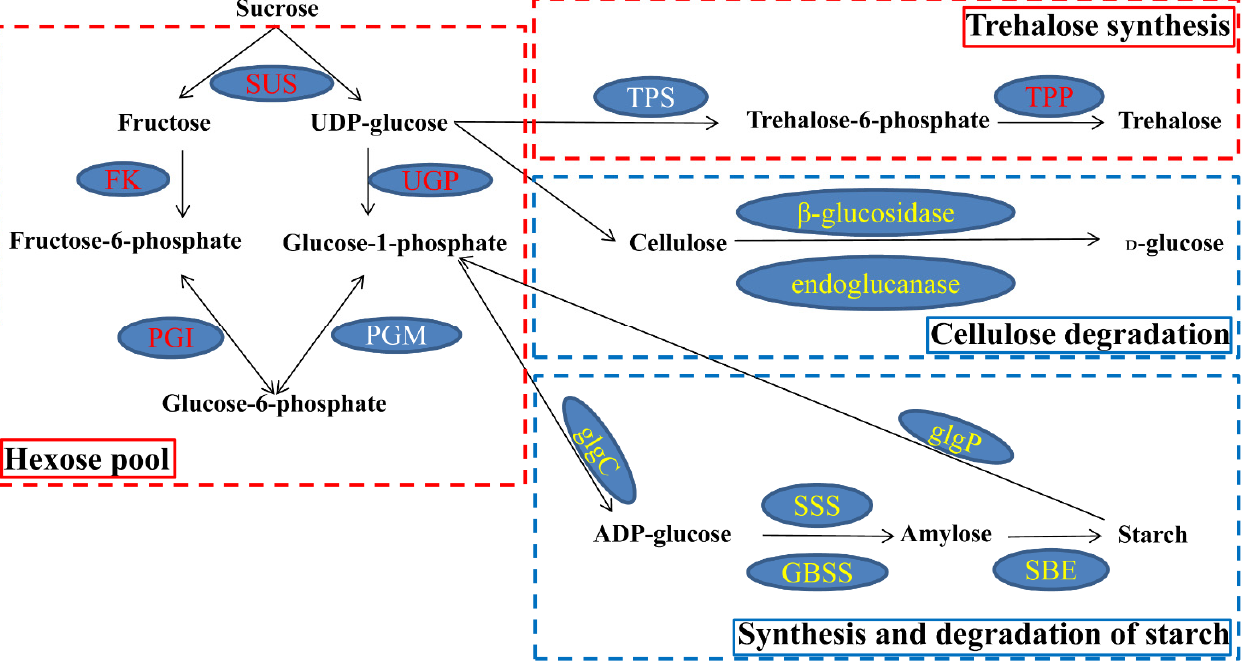
Figure 4. Co-expressed DEGs involved in the ‘starch and sucrose metabolism’ pathway. Transcript levels of DEGs encoding enzymes that increased during waterlogging stress are shown in red; transcript levels of DEGs encoding enzymes that decreased are shown in yellow. One of two DEGs encoding TPS was up-regulated under waterlogging stress. No co-expressed DEGs encoding phosphoglucomutase (PGM) were enriched in the ‘starch and sucrose metabolism’ pathway. Abbreviations are as follows: FK, fructokinase; UGP, UTP-glucose-1-phosphate uridylyl-transferase; PGI, glucose-6-phosphate isomerase; TPP, trehalose-phosphate phosphatase; glgC, ADP-glucose pyro-phosphorylase; glgP: alpha-1,4 glucan phosphorylase; SSS: soluble starch synthase; GBSS, granule-bound starch synthase; SBE, starch-branching enzyme.